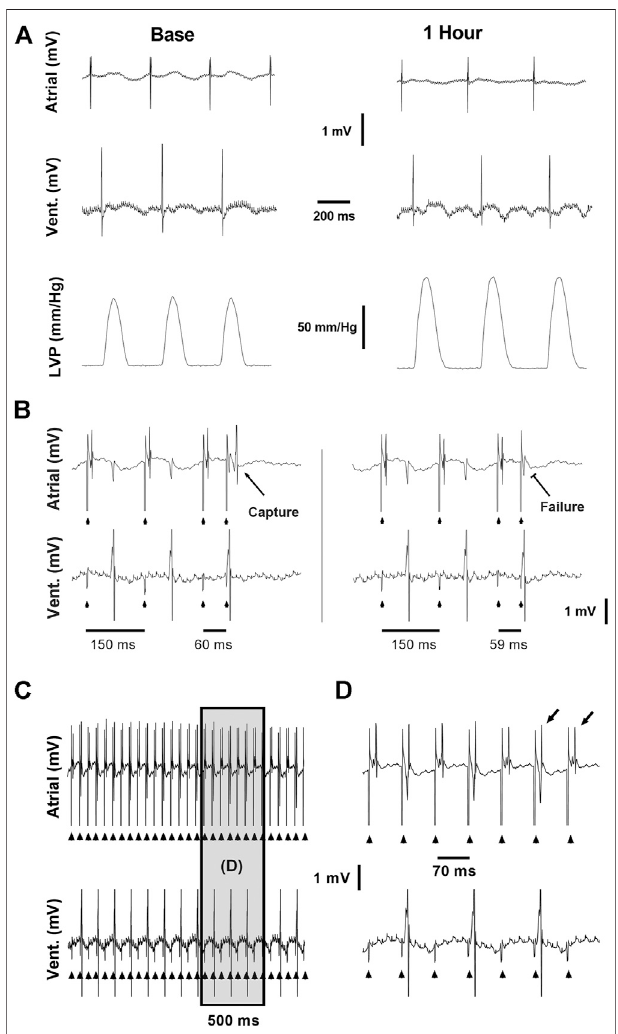
FIGURE1| Examplerecordingsfromthe exvivo experimentalsetup. (A) Baseline (left) and 1 h (right) recordings demonstrating the atrial and ventricularelectricalsignalsand LVP signal used toevaluate theeffects ofCB- 13 under standard conditions without pacing. (B) Conventional S1S2 programmed stimulation protocol applied using a quadripolar electrode attached to the right atrium. Left, Atrial capture following S1S2 of 60 ms. Right, Failure of atrial capture following S1S2 of 59 ms. (C) Continuous assessmentofatrialandventricularsignalsduringatrialtachypacingstudy. (D) Enlarged segment of the recording in C demonstrating the clear and precise ability to determine 1:1 atrial capture during the tachypacing protocol used in this study. Note beat-to-beat oscillation in the shape of the atrial signal (alternans) often observed when the fast pacing cycle length was reaching the minimal value that was able to maintain 1:1 atrial